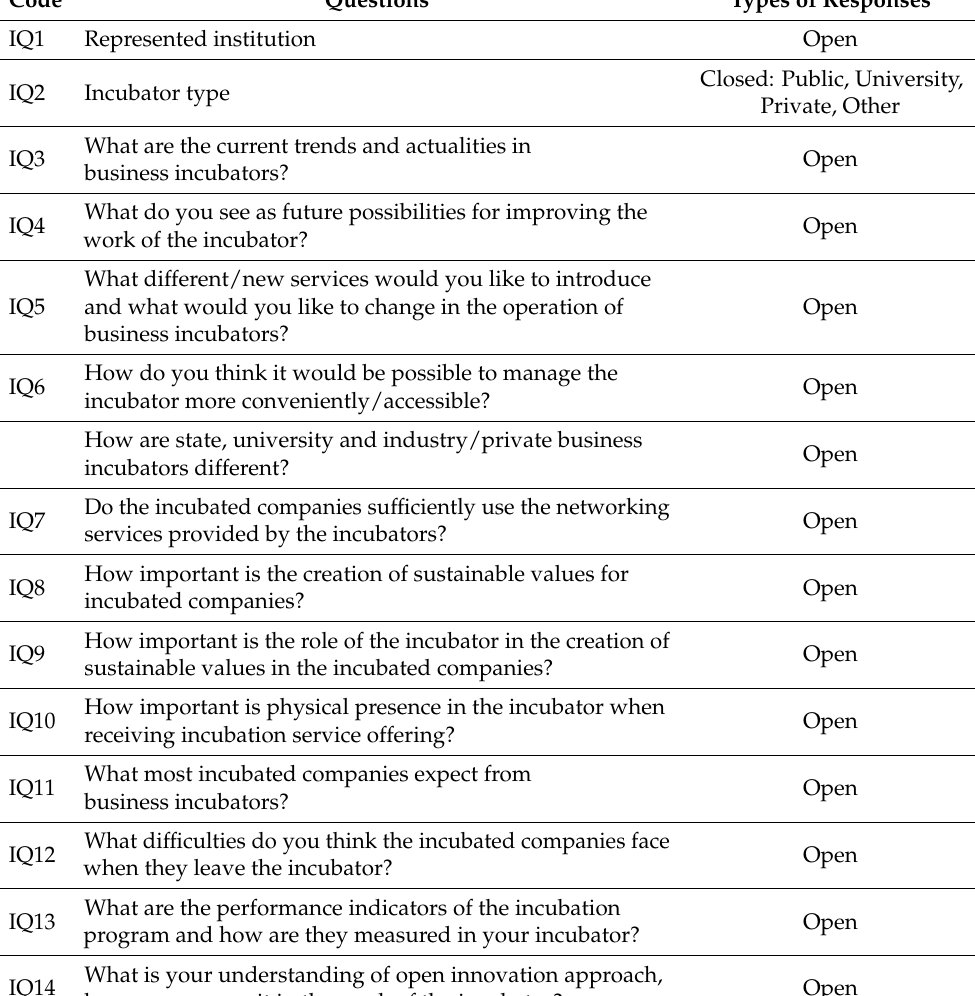
Table A1. Questions of the interviews of the incubation